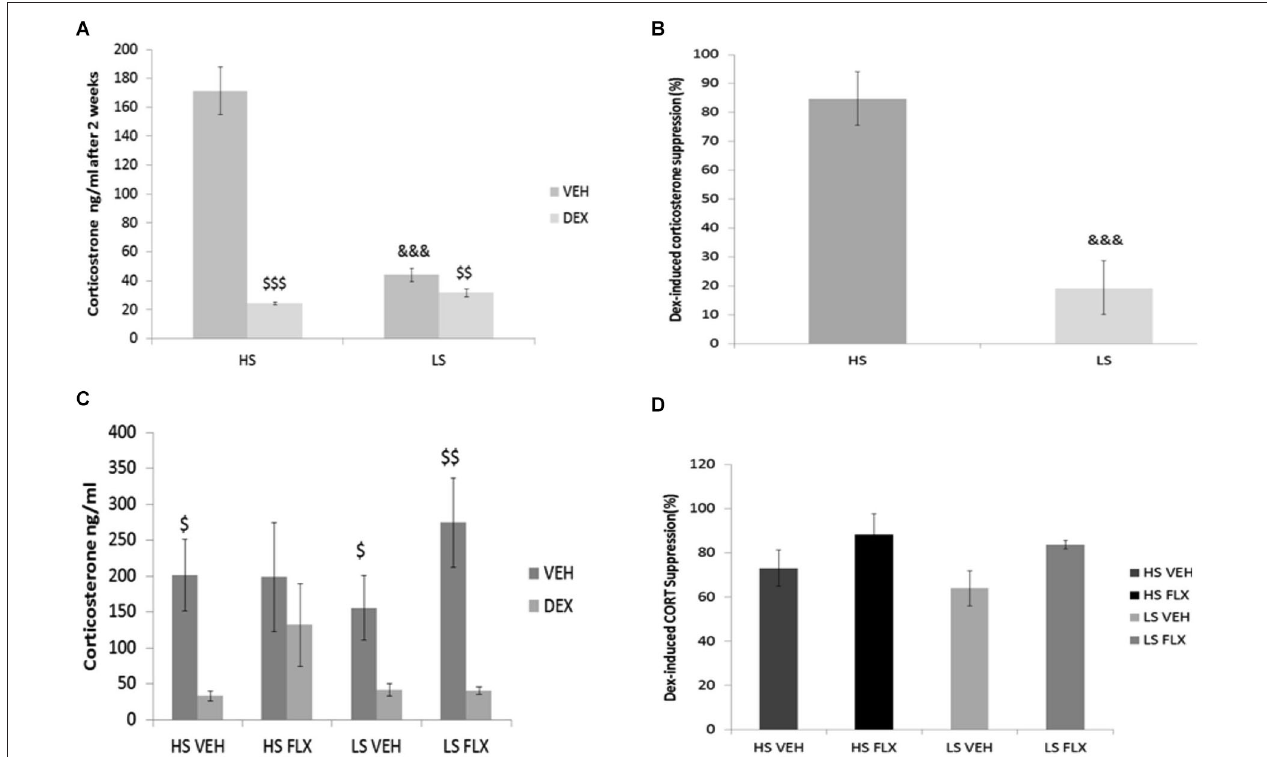
vehicle or dexamethasone at the end of UCMS. (D) Suppression rate after 9 weeks of UCMS. Figures 4A,B : n = 17 in each experimental condition. Figures 4C,D : HS VEH ( n = 10), HS FLX ( n = 7), LS VEH ( n = 11), LS FLX ( n = 6). HS vs. the corresponding LS condition: &&& p < 0.001;